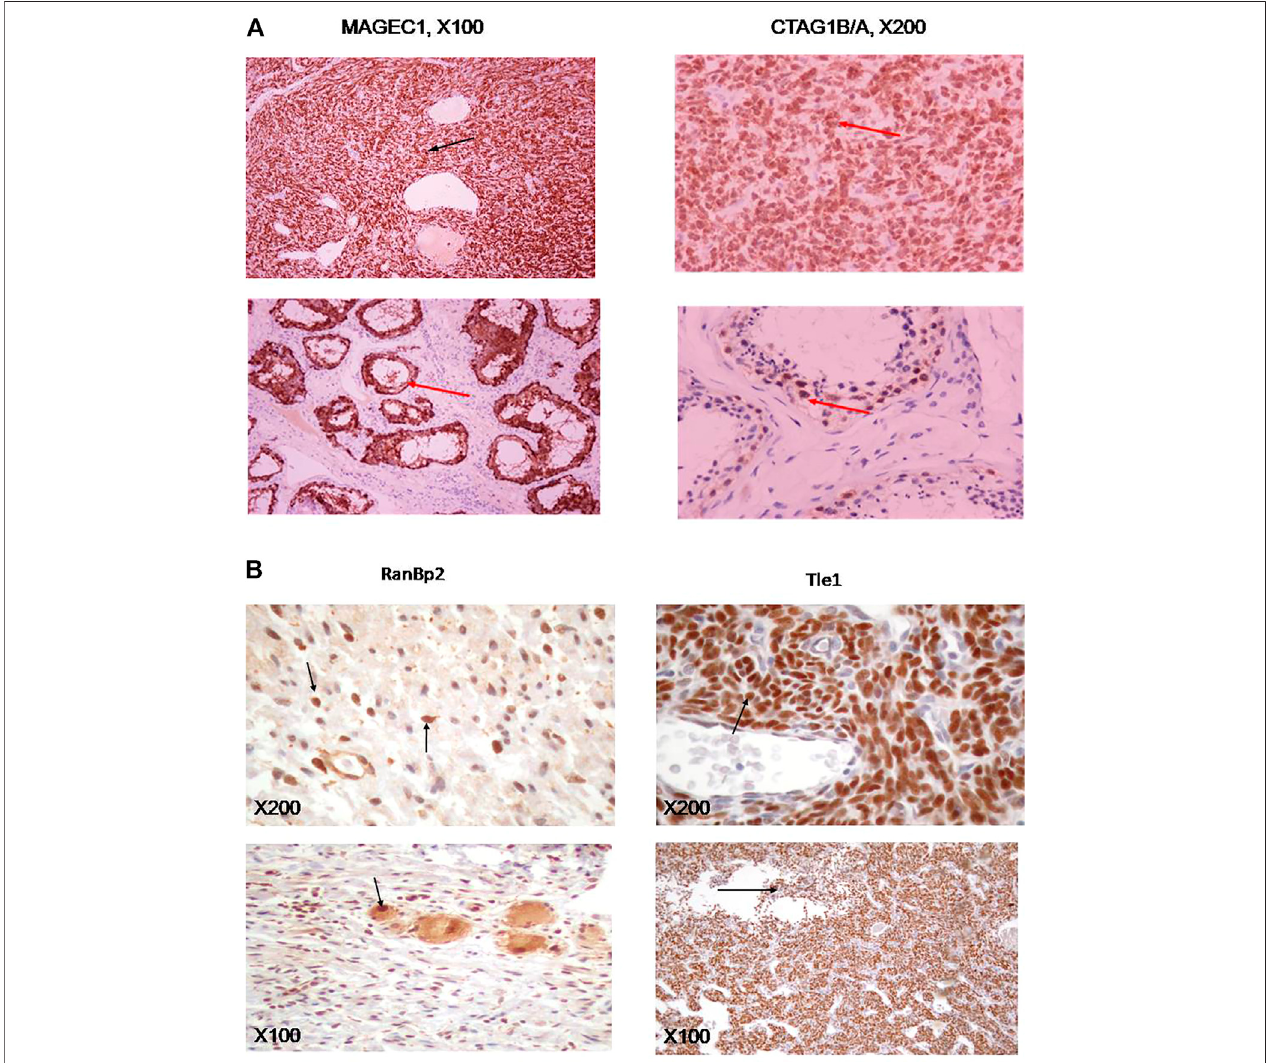
FIGURE 4 | (A) Immunohistochemical stains of synovial sarcoma specimens for MAGEC1 (left panel), or CTAG1B/A (right panel), as well as appropriate controls (testicular tissue, lower panels). (B) Immunohistichemical stains of ganglioneuroma samples for RANBP2 (left panels) and synovial sarcomas for TLE1 (right panels). Antibodies used are described in Materials and Methods. Magni fi cation was at 100× (upper panels) or 40× (lower panels) on a NIKON Diaphot 200/300 inverted microscope.